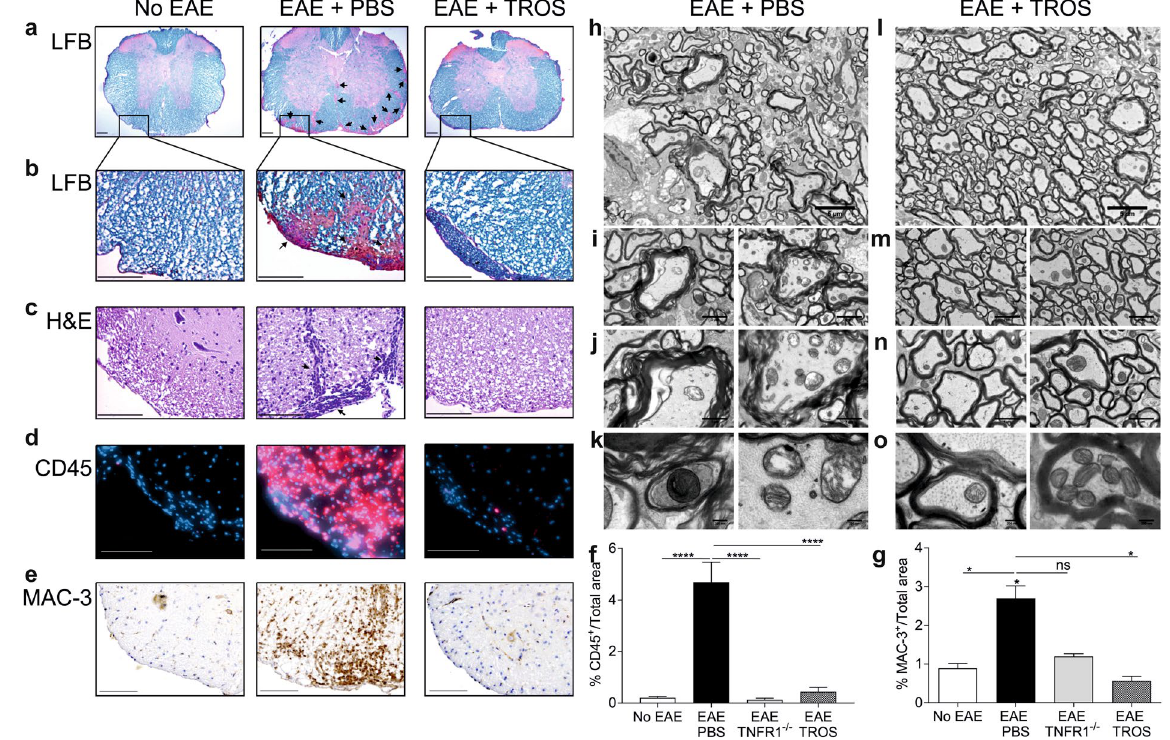
Figure 5. ( a – o ) Spinal cords of TROS-treated mice, examined by histological and immunohistochemical (IHC) stainings and with transmission electron microscopy (TEM), show less damage, less demyelination and cellular infiltrates. hTNFR1 Tg and TNFR1 − / − mice were immunized with MOG 35-55 -peptide and pertussis toxin to induce EAE. Spinal cord sections were obtained from healthy hTNFR1 transgenic (Tg) (no EAE, n = 4), EAE TNFR1 − / − (n = 3) and EAE hTNFR1 Tg mice 16 days post-immunization (PI). The EAE hTNFR1 Tg mice were therapeutically treated on days 8 and 12 PI with 500 µ g TROS (n = 3) or PBS (n = 4), injected intraperitoneally (i.p.). ( a – c ) Spinal cords were analyzed with Luxol Fast Blue (LFB) staining for demyelination ( a , b ) and H&E staining for inflammation ( c ). Demyelination and infiltrating cells are indicated with arrows. ( d – g ) IHC was performed on spinal cords for CD45 + lymphocyte infiltration ( d ) and MAC-3 + macrophages ( e ). CD45 + and MAC3 + cells ( f and g ) were quantified with Volocity in the whole spinal cord section and normalized to the total spinal cord area. ( h – k ) Representative images of spinal cords imaged by conventional transmission electron microscopy (TEM) of PBS- and TROS-treated EAE-diseased hTNFR1 Tg mice 16 days PI. PBS-treated mice (n = 2) show irregular, swollen axons with wavy decompacted myelin sheaths that sometimes lost the contact with the axons ( i–j ). The mitochondria ( k ) are abnormal, enlarged and disintegrating or more condense. ( l – o ) Spinal cords of TROS-treated mice (n = 3) have a normal healthy morphology of myelinated axons with tightly compacted myelin sheaths and normal mitochondria ( o ). Data information: Representative images of spinal cord sections of all groups are shown. Scale bars represent 200 µ m in ( a ) and 100 µ m in ( b – d , f ). Magnification of the TEM images are 1500x, scale bar 5 µ m ( h , l ), 5000x, scale bar 2 µ m ( i , m ), 10,000x, scale bar 1 µ m ( j,n ) and 30,000x, scale bar 200 nm ( k , o ). Bars represent mean ± SEM. Data were analyzed with a one-way ANOVA test. * 0.01 ≤ p < 0.05; ** 0.001 ≤ p < 0.01; *** 0.001 ≤ p 0.0001, **** p < 0.0001. Non-statistically significant differences are not indicated on the